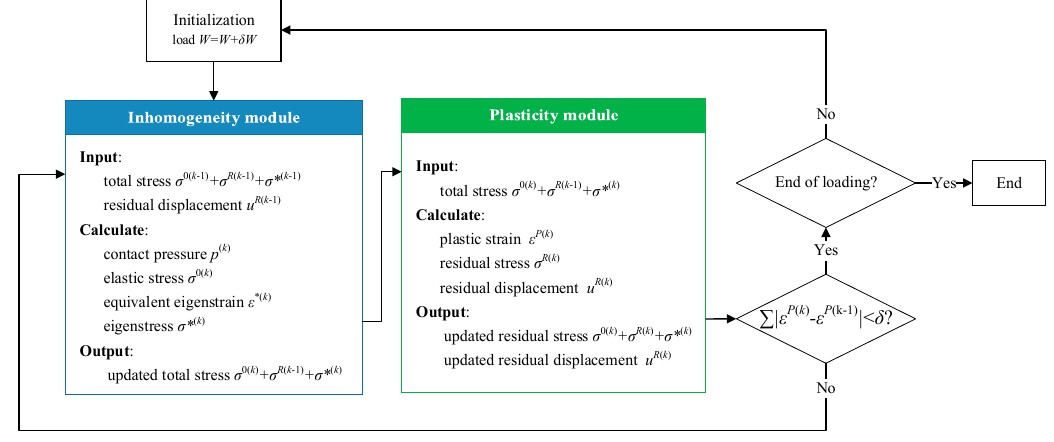
Figure 7. Flow chart of the algorithm and steps for solving inhomogeneous contact elasto-plastic problems.